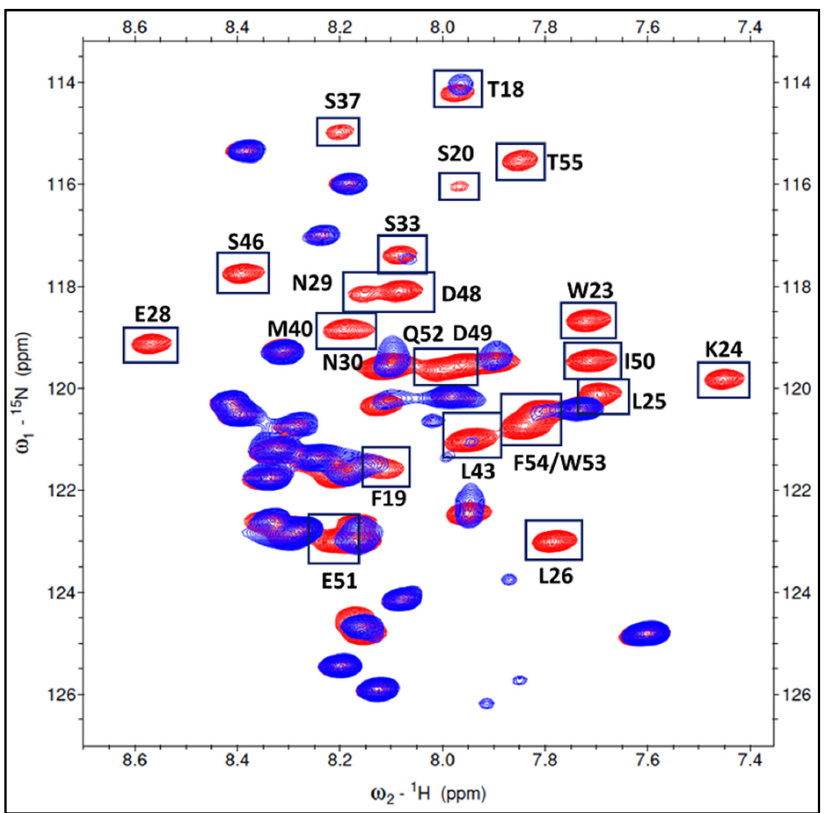
Figure 1. The overlaid of two HSQC spectra. The free 15 N labeled p53 1-73 spectrum was showed in red. The mix of the p53 1-73 (with 15 N labeled) and unlabeled S100P with 1:1 ratio was showed in blue. The cross peaks labeled with a box in this figure were the residues in p53 1-73 domain that interacted with S100P.